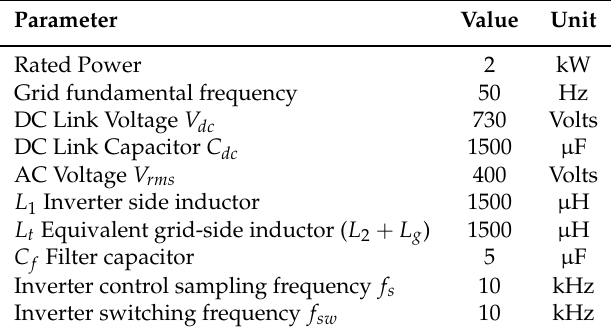
P ARAMTERS OF INVERTER FOR EXPERIMENT VERIFICATION